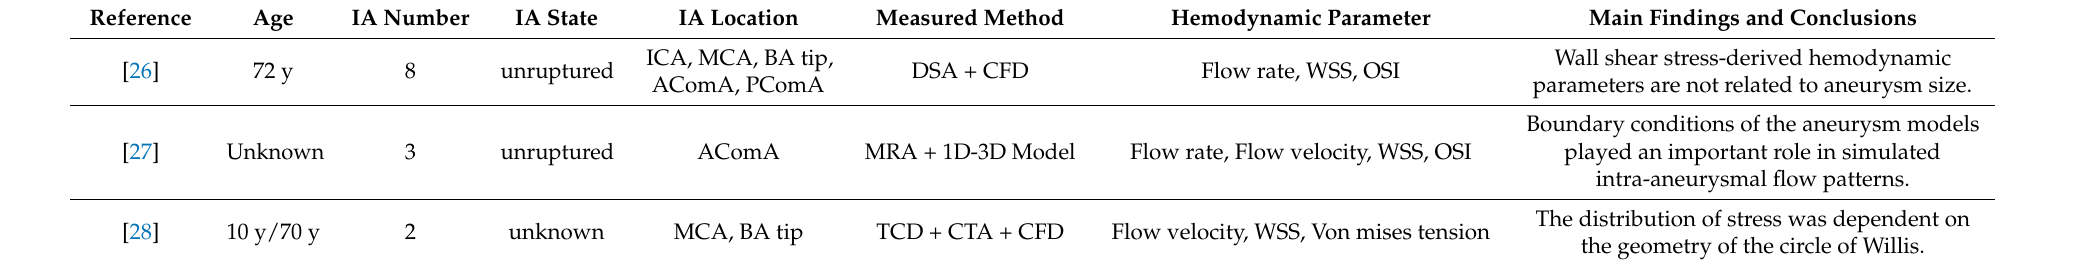
Table 1. Study characteristics of three selected case-report after full-text